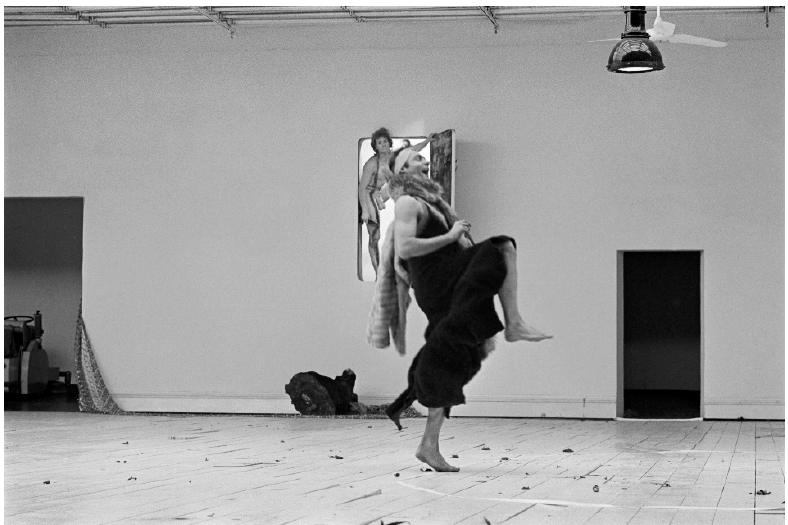
Figure 3. Pentheus taking some exaggerated dancing poses, just like the ones depicted in the Pronomos Krater, in Die Bakchen directed by Klaus Michael Grüber for the Berlin Schaubühne, 1974. Deutsches Theatermuseum München, © Helga